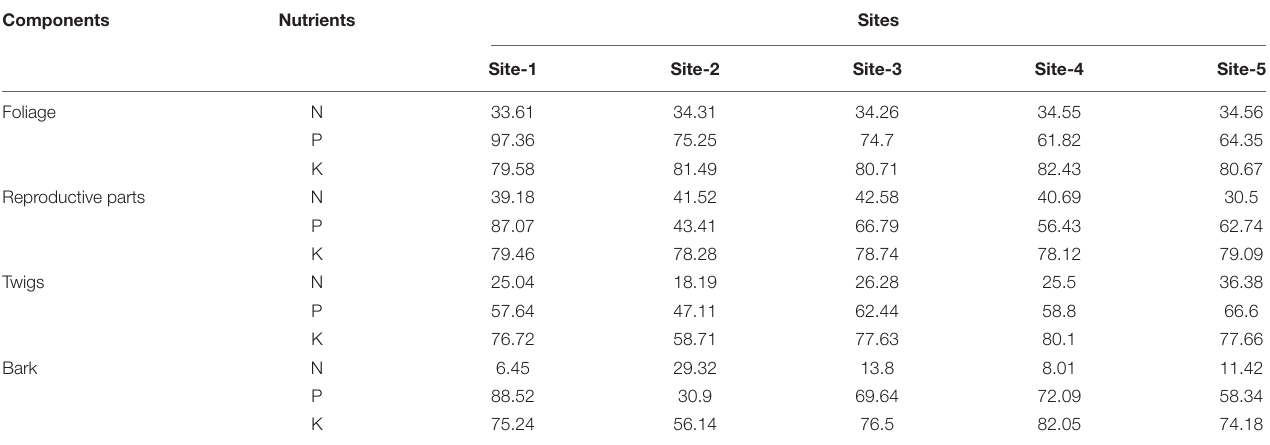
TABLE 4 | Percentage retranslocation of nutrient from different plant parts during